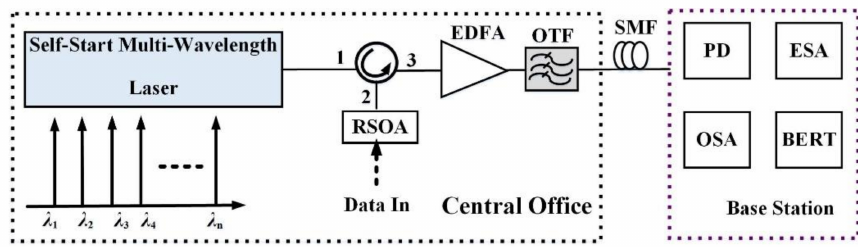
Figure 7. The architecture of the self-start multi-wavelength laser for RoF